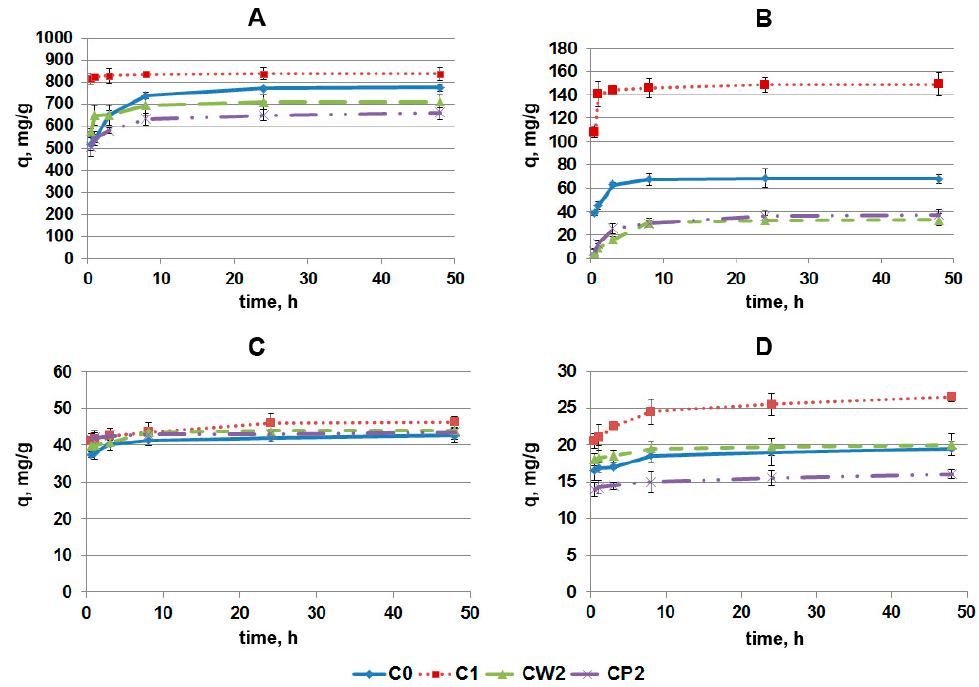
Figure 4. The kinetic curves of SRL adsorption onto AC. High SRL concentrations (1 mL of mixture contained 100 µ g of AC and 90 µ g of SRL) in PBS ( A ) and in BP ( B ). Low SRL concentrations (1 mL of mixture contained 200 µ g of AC and 10 µ g of SRL) in PBS ( C ) and in BP ( D ). The maximum possible SRL adsorption was 900 mg/g for ( A , B ) and 50 mg/g for ( C , D ). According to the intensity of absorption of SRL onto AC at the high SRL concentration (90 µ g/mL) in PBS, AC fractions can be arranged in the following order: C1 > C0 > CW2~CP2, and fraction C1 and CW2/CP2 showed a 4.5-fold difference in efficiency. At low SRL concentration (90 µ g/mL): C1 > CW2~C0 > CP2, with a 1.7-fold difference in efficiency for C1 and